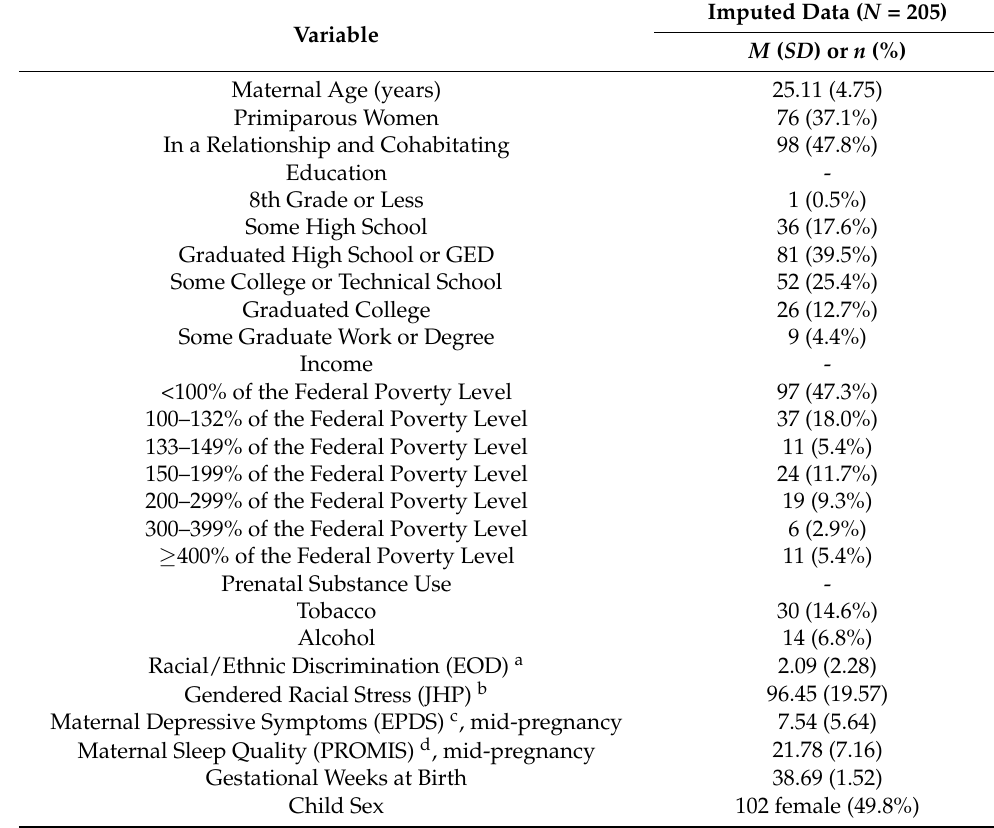
Table 1. Descriptive